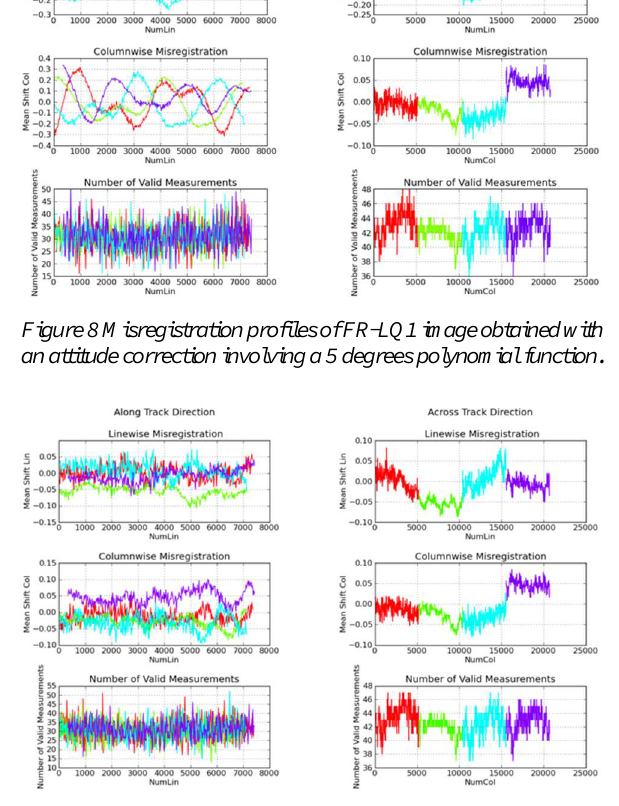
Figure 9 Misregistration of FR-LQ1 image obtained with an attitude correction involving 30 cubic splines and detectors position